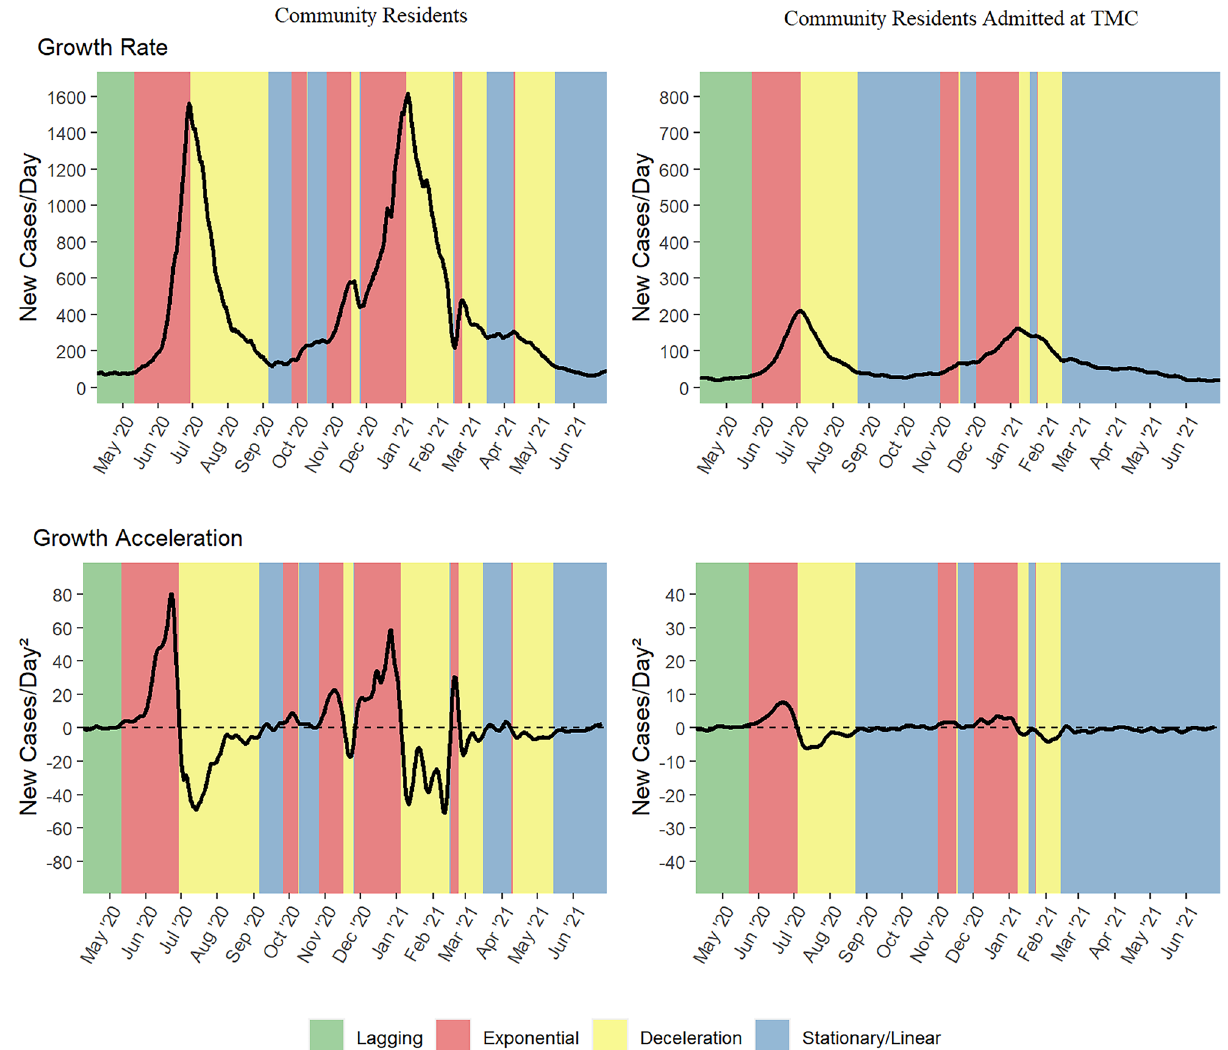
CoV-2 test (right) from April 8, 2020 to June 30,